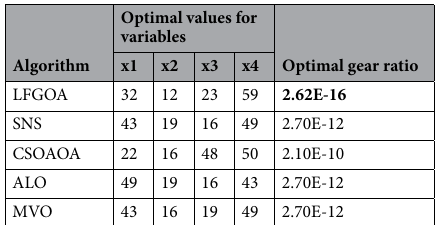
Table 21. Comparison results of the gear train design problem. The best of the comparison results are in [bold].